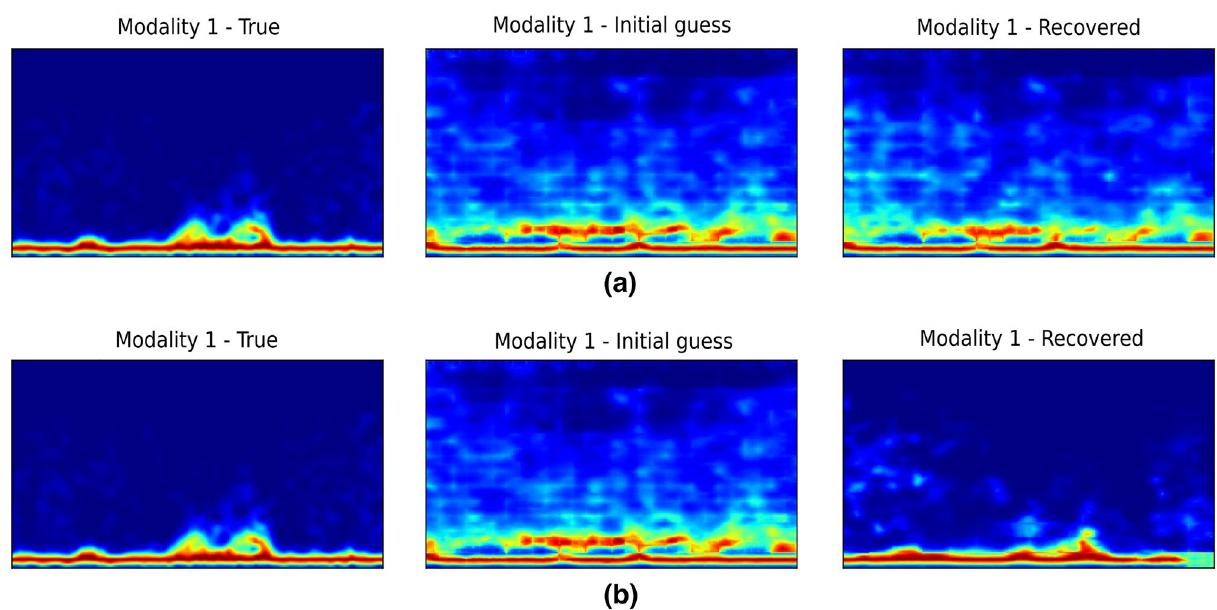
Figure 5. Reconstruction examples showing the benefit of multimodal system compared to a unimodal system. Modality 1 is subsampled data with 1 single measurement while modality 2 has full information (no noise and no loss of data). Additive Gaussian noise with a standard deviation of 0.1 is considered in this example: ( a ) reconstruction with modality 1 only, ( b ) reconstruction with both modalities 1 and 2. Left column shows true spectrogram sample, middle column shows reconstruction with initial guess (no optimization) while right column shows reconstruction with ˆ z MAP . Adding modality 2 during reconstruction stage helps in the sample recovery of modality